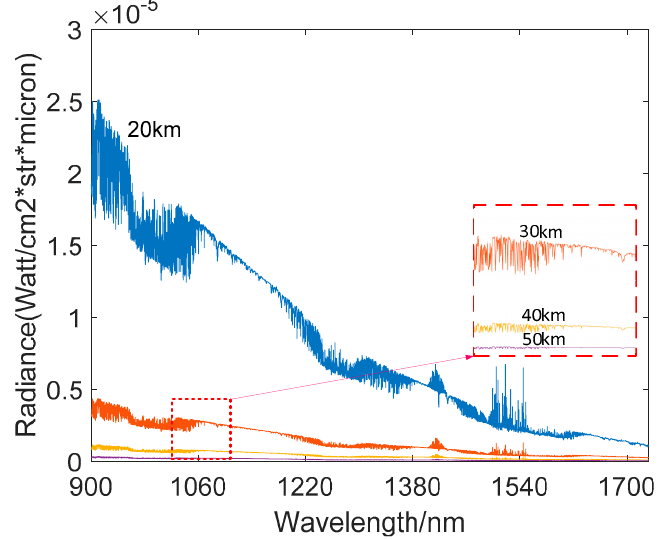
Figure 7. Atmospheric background radiation at 20 km, 30 km, 40 km, and 50 km.